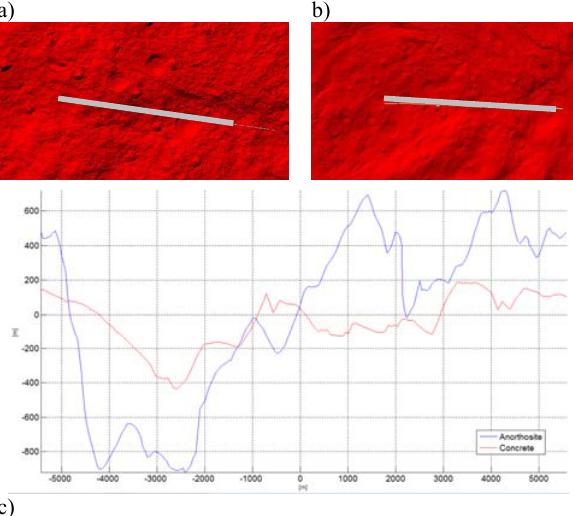
Figure 11: a) cross section on Anorthosite DTM; b) cross section on Concrete DTM; c) plot of the profiles at the Mercury scale